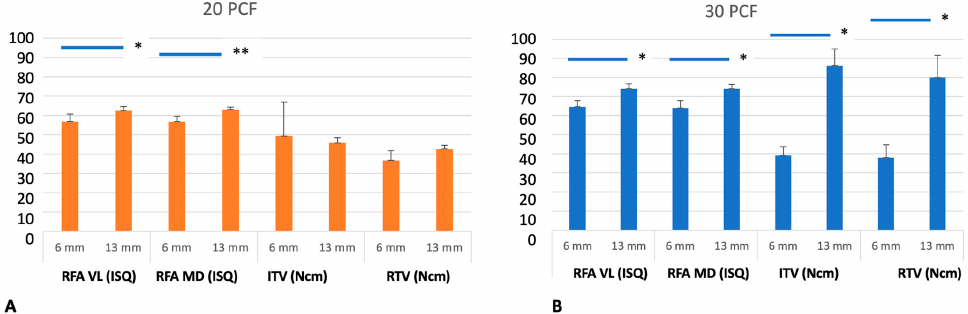
Figure 2. Measurements of primary stability on polyurethane blocks of 20 PCF ( A ) and 30 PCF ( B ); * p -value = 0.027, and ** p -value = 0.005.